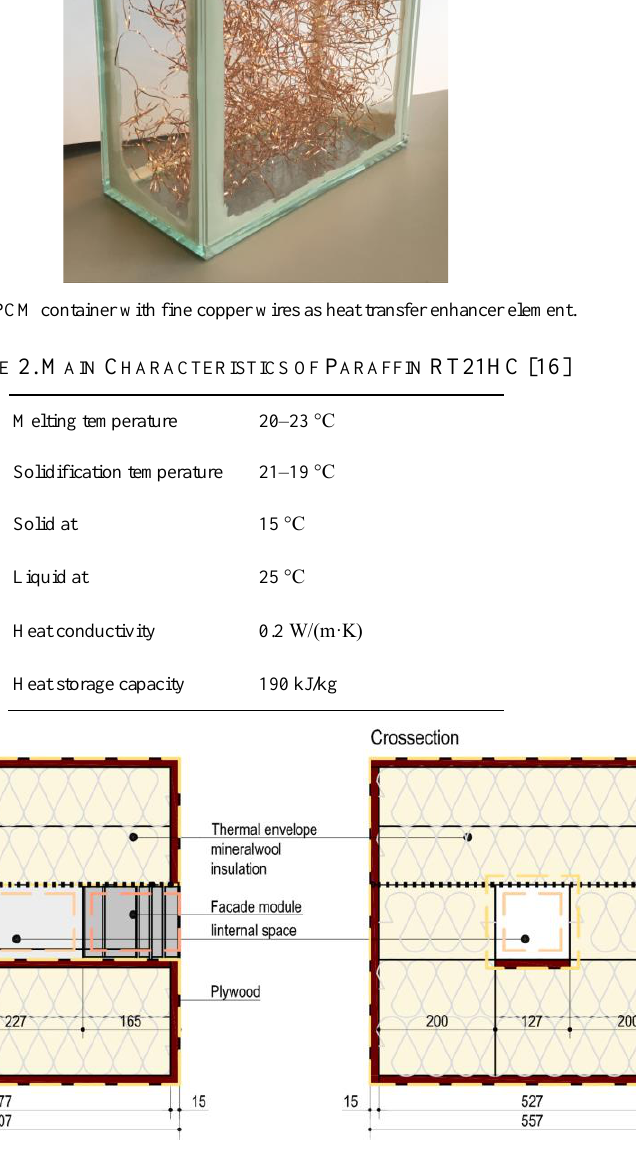
Fig. 3. Test box section (units in